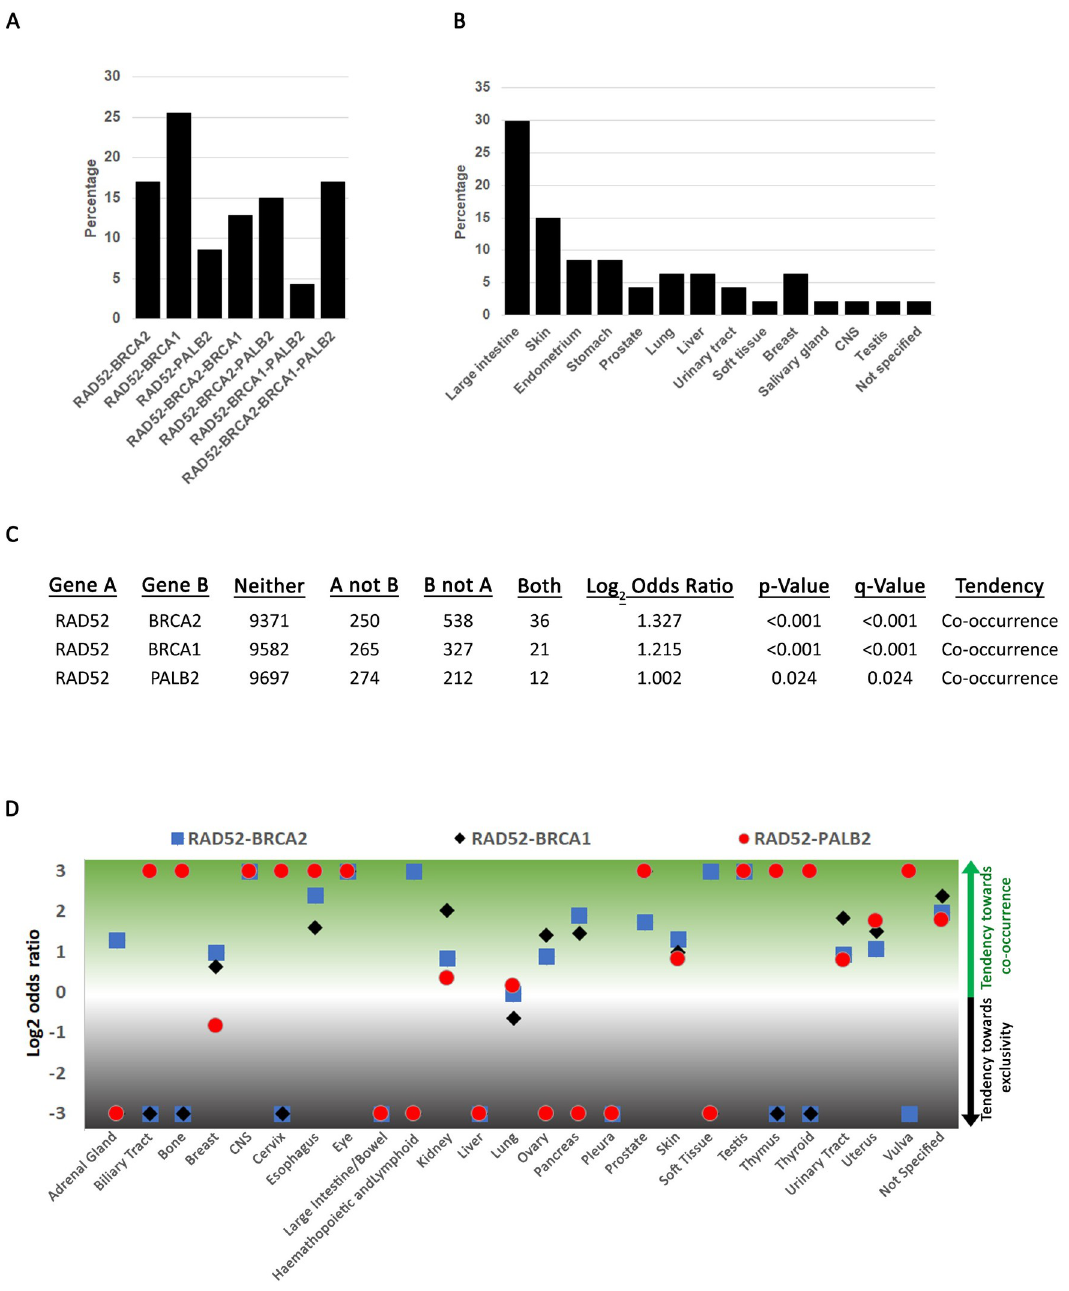
Fig 2. Co-occurring mutations in RAD52 and the BRCA2-BRCA1-PALB2 axis. A . Percent co-occurring mutations between the four genes using data from Table 1 . Total percentage (100%) represents all mutations in Table 1 . B . Distribution of co-occurring mutations among the different cancer types. A graphical representation of the data from Table 1 . C . Pan-cancer statistical analysis if co-occurring mutations using cBioPortal (www.cbioportal.org). D . Statistical analysis of co-occurring mutations by tissue using